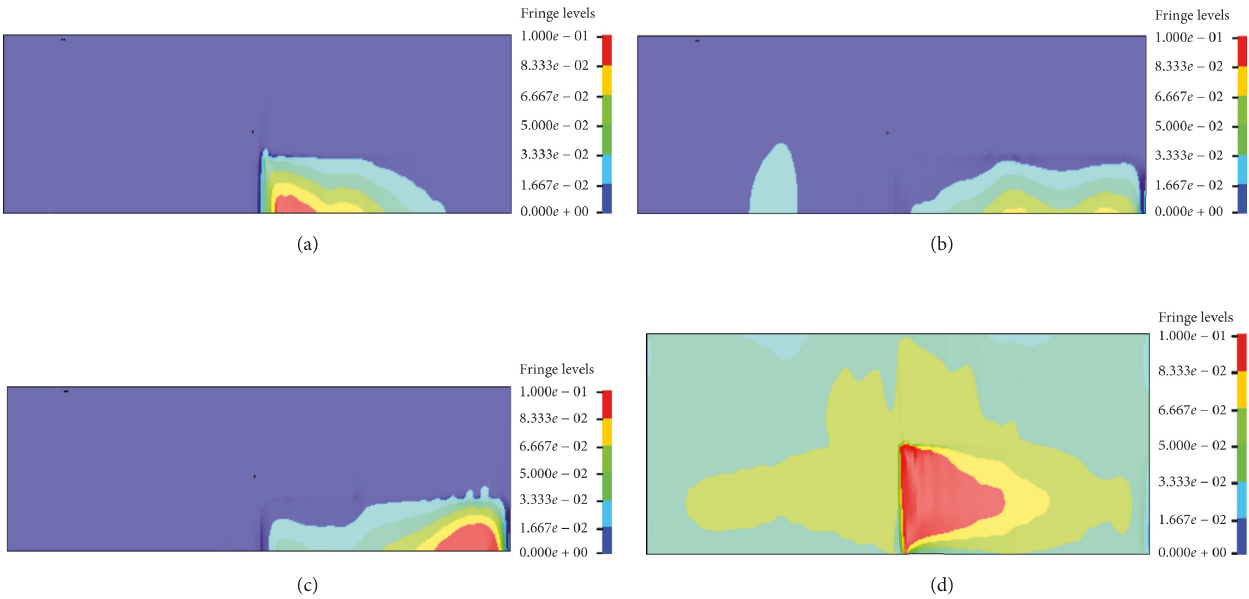
Figure 14: Fringe plot of the final displacement of the deck (top view, unit: m). (a) Position 1. (b) Position 2. (c) Position 3. (d) Position 4.